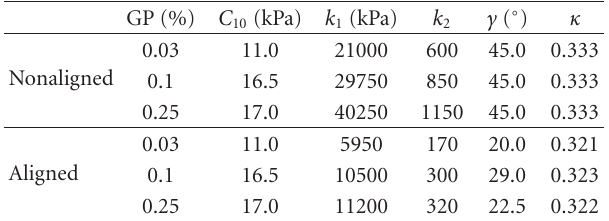
Table 1: Summary of model parameters for nonaligned and aligned collagen gels crosslinked with 0.03%, 0.1%, and 0.25%